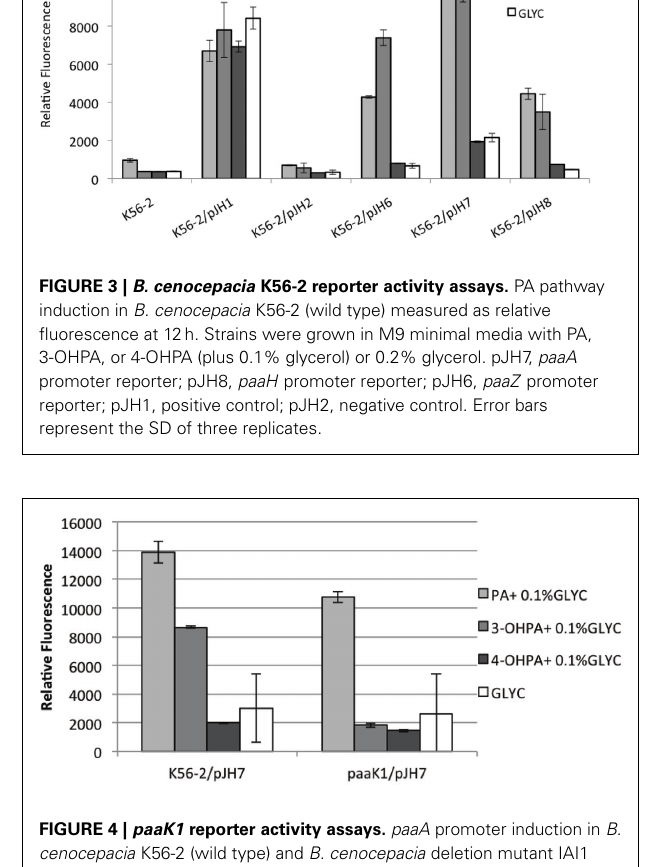
FIGURE 4 | paaK1 reporter activity assays. paaA promoter induction in B. cenocepacia K56-2 (wild type) and B. cenocepacia deletion mutant IAI1 ( paaK1 ) measured as relative fluorescence at 12h. Strains were grown in M9 minimal media with PA, 3-OHPA, or 4-OHPA (plus 0.1% glycerol) or 0.2% glycerol. pJH7, paaA promoter reporter plasmid. Error bars represent the SD of three